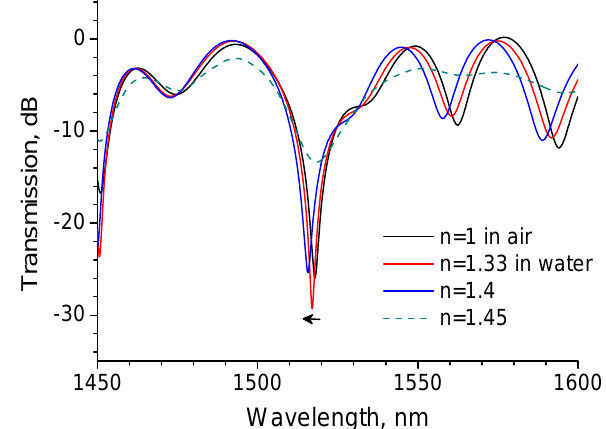
Figure 2. Transmission spectra of a 30-mm-long straight LPG surrounded by a medium having a refractive index that is lower than that of silica.